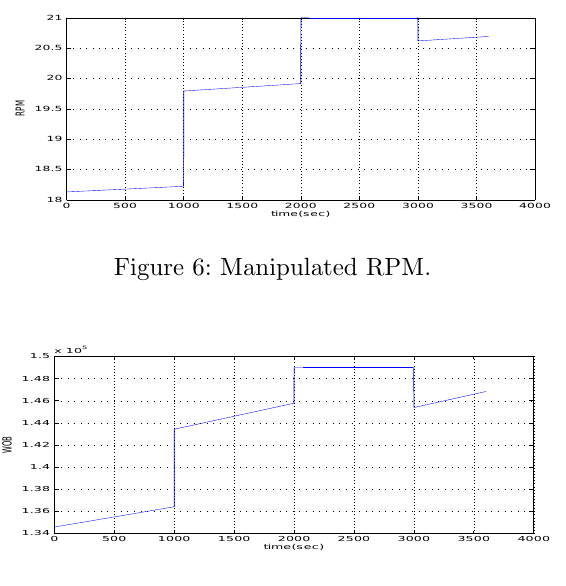
Figure 7: Manipulated